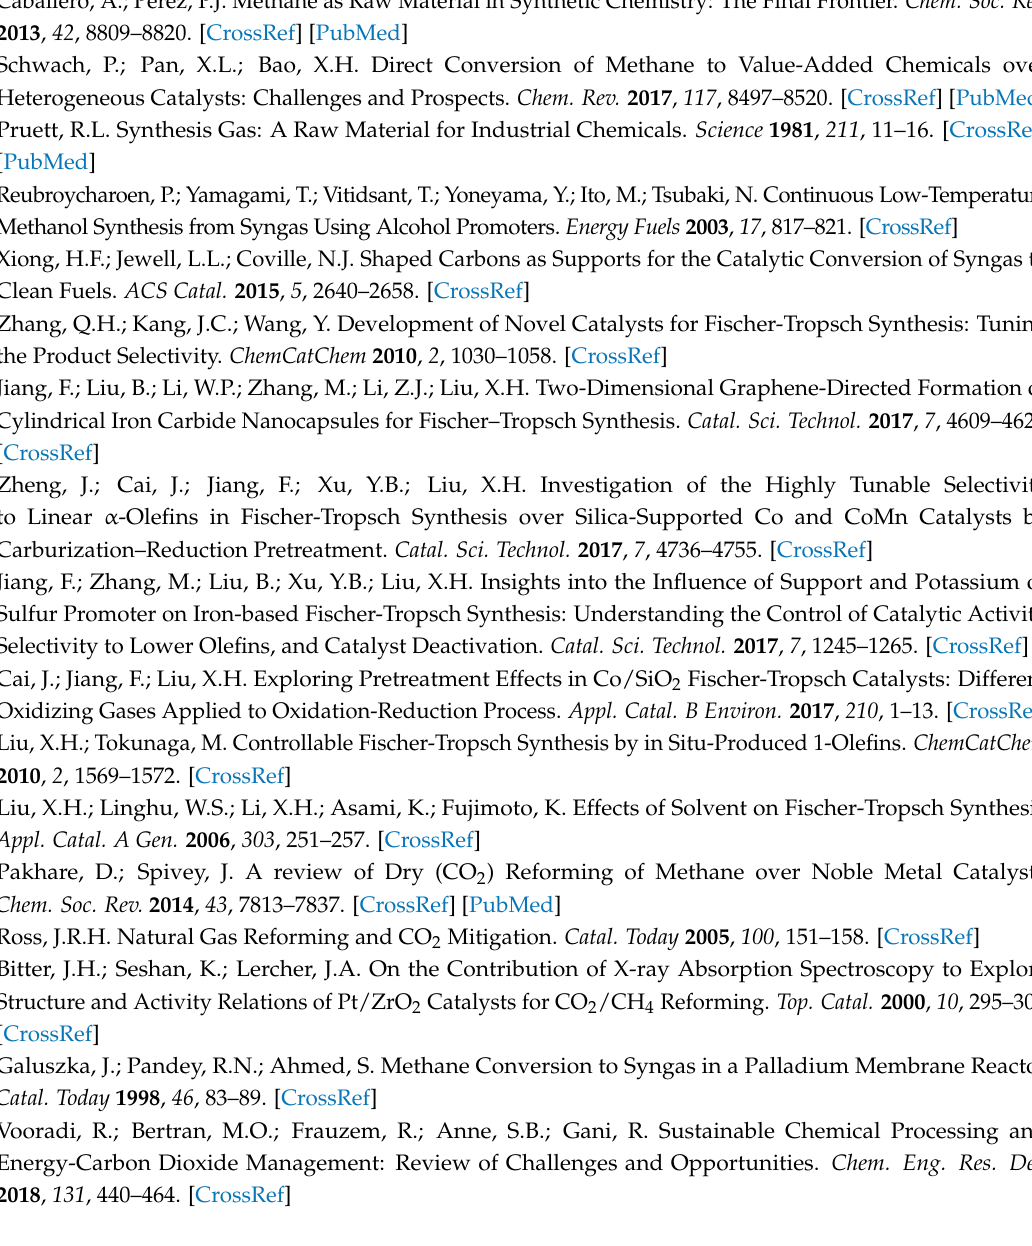
Figure S1: XRD patterns of fresh Ni/SiO 2 catalysts prepared with the combustion method by using different ratios of C 2 H 5 NO 2 to NH 4 NO 3 , Figure S2: TEM images of spent Ni/SiO 2 -0/0 catalyst ((a) and (b)) and Ni/SiO 2 -2/1 catalyst ((c) and (d)) after 50-hours of reaction, Table S1: The equilibrium conversions of CH 4 and CO 2 , H 2 /CO molar ratio, and selectivity to H 2 O calculated by HSC chemistry 6.0, Table S2: BET surface area of as-prepared Ni/SiO 2